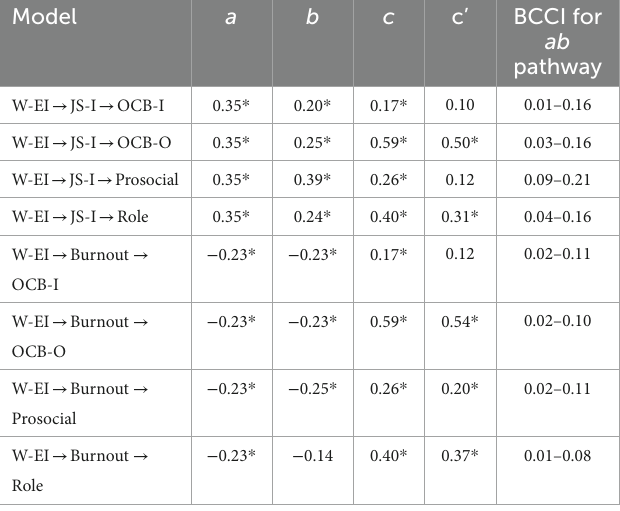
TABLE 7 Mediation results involving job satisfaction (interpersonal features) and burnout, Study 3.